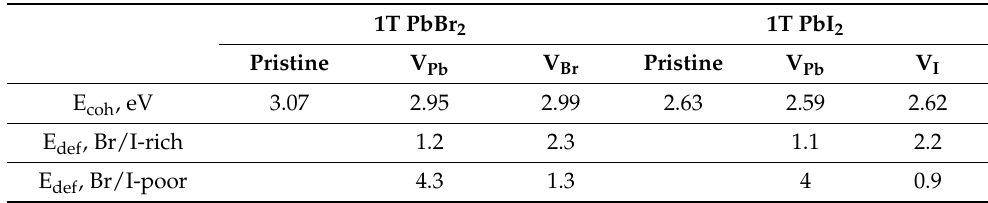
Table 2. The cohesive and defect formation energies in charge neutral state for the PbBr 2 compared to PbI 2 (from Wang et al. [38]). All values are in eV.